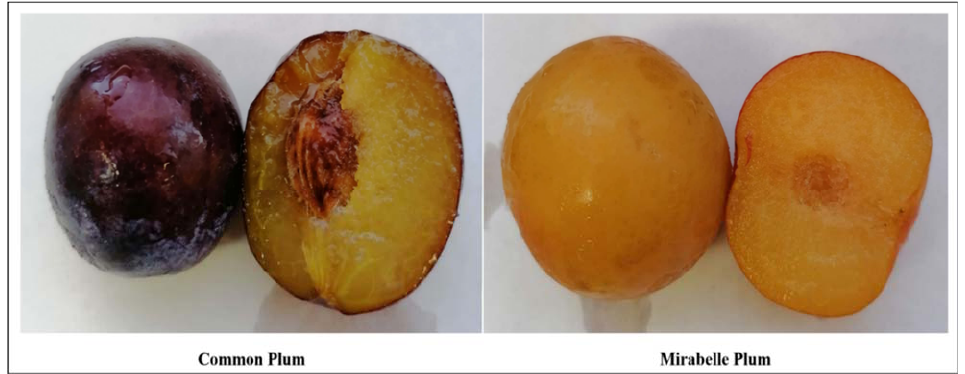
Figure 1. Plum varieties, collected from a local cultivator in the Campania Region (Italy). P. domestica L. subsp. domestica (Common plum) and P. domestica L. subsp. syriaca (Mirabelle